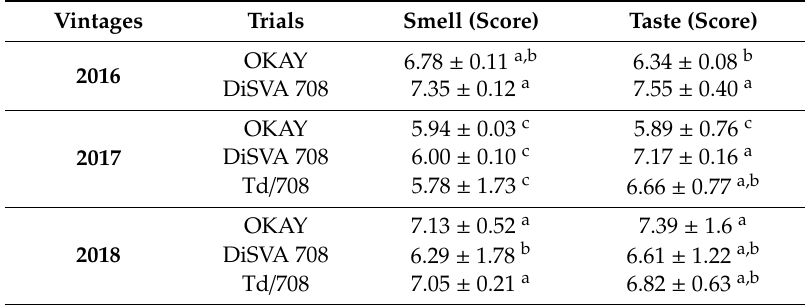
Figure 3. Principal Component Analysis based on the data regarding the main by-products of fermentation and volatile compounds of the wines obtained by pure and sequential fermentations for all vintages: 2016, 2017, 2018. The abbreviations Td / DiSVA 708 indicate the sequential fermentations carried out by T. delbrueckii / S. cerevisiae DiSVA 708. Table 4. Sensory analysis of the wines obtained by pure and sequential fermentations in three vintages. Pure culture was carried out by S. cerevisiae OKAY and DiSVA 708. The abbreviations Td / 708 indicate sequential fermentations carried out by T. delbrueckii / S. cerevisiae DiSVA 708, respectively. Data are means ± standard deviations. Values displaying di ff erent superscript letters ( a,b,c ) within each column are significantly di ff erent according to Duncan tests ( p < 0.05).